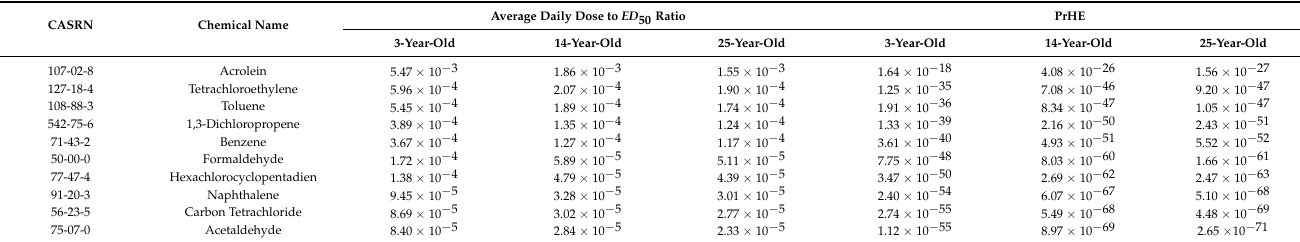
Table 2. Combined ingestion and inhalation exposure as a fraction of ED 50 and estimated probability of occurrence of health effects ( PrHE ) for 10 chemicals with top PrHE , ranked in